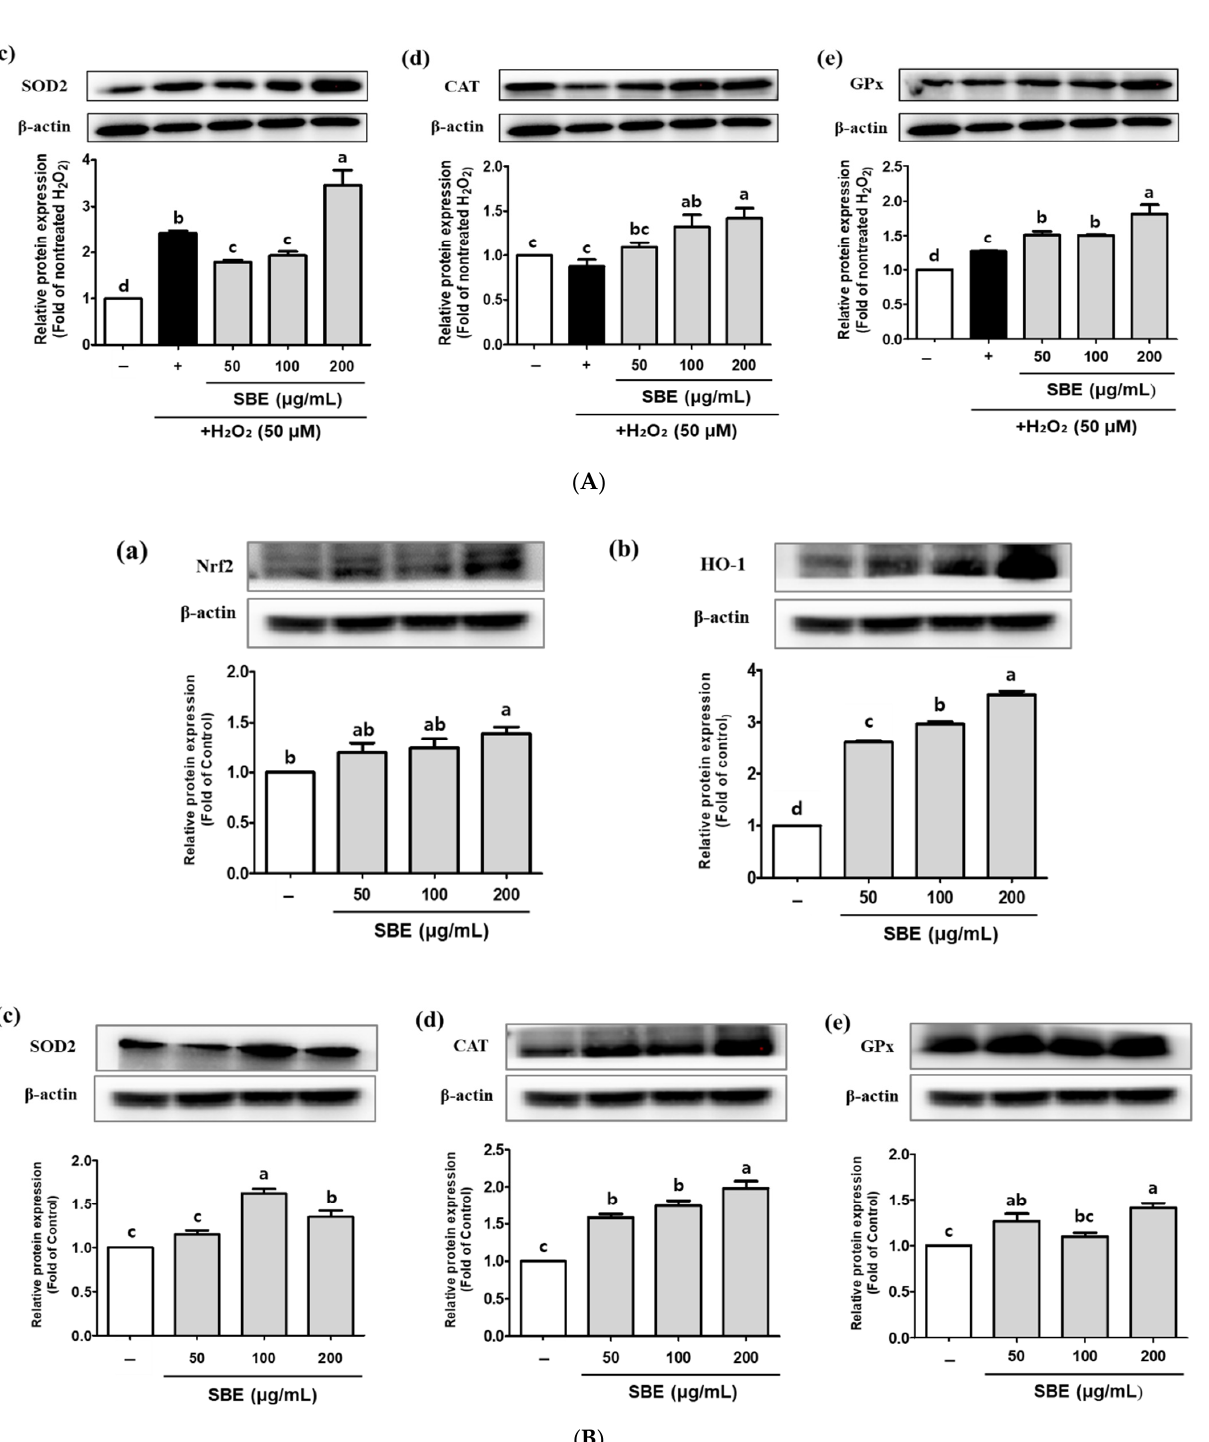
Figure 4. ( A ) SBE (50, 100, and 200 µg/mL) increased the levels of antioxidant-related proteins in H 2 O 2 -treated PC12 cells. ( a – e ) Nrf2, HO-1, SOD2, CAT, and GPx levels determined by Western blot- ting with densitometry. ( B ) SBE (50, 100 and 200 µg/mL) increased the levels of antioxidant-related proteins in non-treated PC12 cells. ( a – e ) Nrf2, HO-1, SOD2, CAT, and GPx levels determined by Western blotting with densitometry. Values are presented as mean ± SD from three experimental replicates. Significance was statistically defined with small letters at p < 0.05. Protein band quantifica- tion was conducted using Image J software. All protein values were divided by the relative β -actin values in their respective